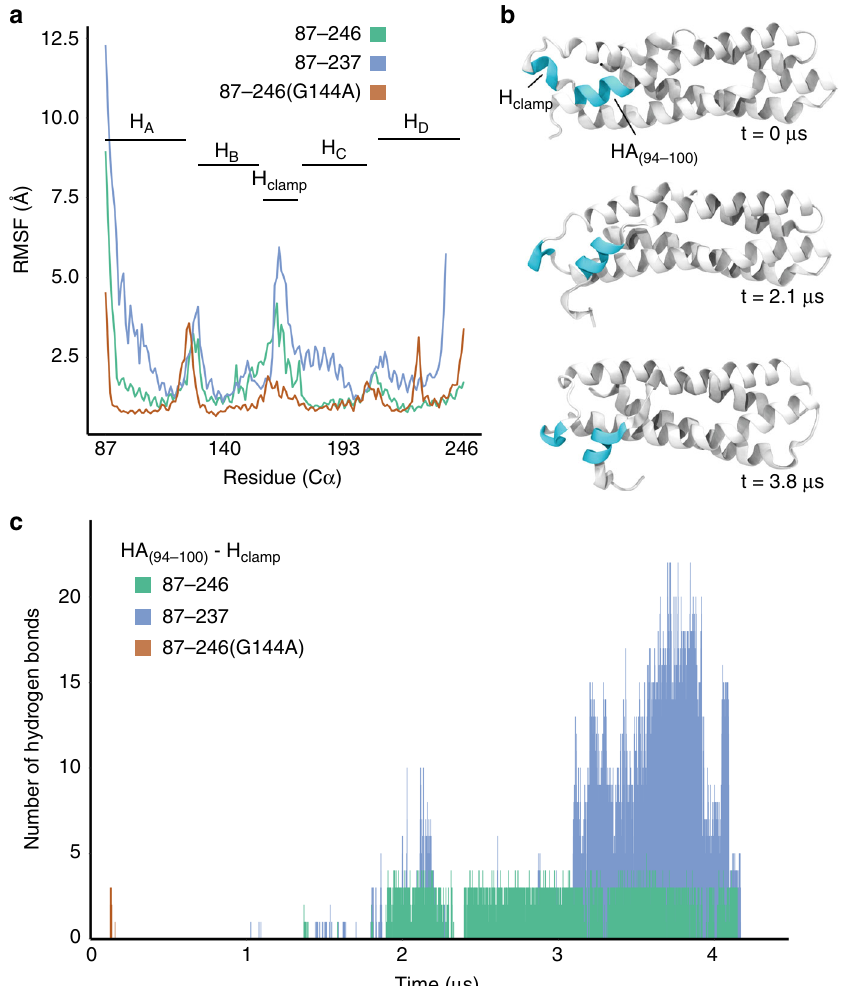
Fig. 3 Molecular dynamics simulations show that IncA 87 – 246 monomer is stable. a Root-mean-square fl uctuation (RMSF) analysis of the three simulations performed: IncA 87 – 246 (green line), IncA 87 – 237 (blue line), and IncA 87 – 246(G144A) (orange line). Prior to calculating RMSF, each of the three trajectories was aligned by minimizing the root-mean-square deviation (RMSD) of backbone atoms between the equilibrated structure and every subsequent frame. b Three snapshots ( t = 0 µ s, t = 2.1 µ s, t = 3.8 µ s) of the observed conformational change during the IncA 87 – 237 simulation. The two regions of interest, H clamp and H A(94 – 100) , are colored in cyan. c Bar plot of the number of hydrogen bonds occurring between the H clamp and H A(94 – 100) over the course of all three simulations. Hydrogen bonds were identi fi ed using a contact-analysis between hydrogen, oxygen, and nitrogen atoms within a cutoff of 3.2